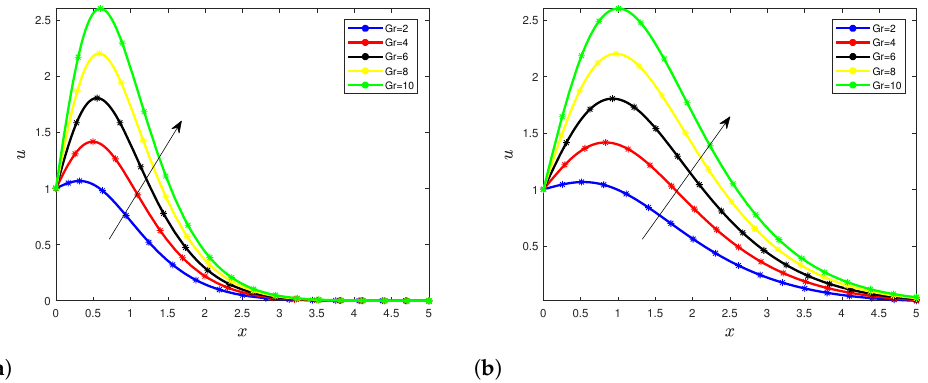
Figure 8. Dynamics of the fractional diffusion reaction equation with various orders with, respectively, τ = 0.5 ( a ) and τ = 1.5 ( b ) with Pr =